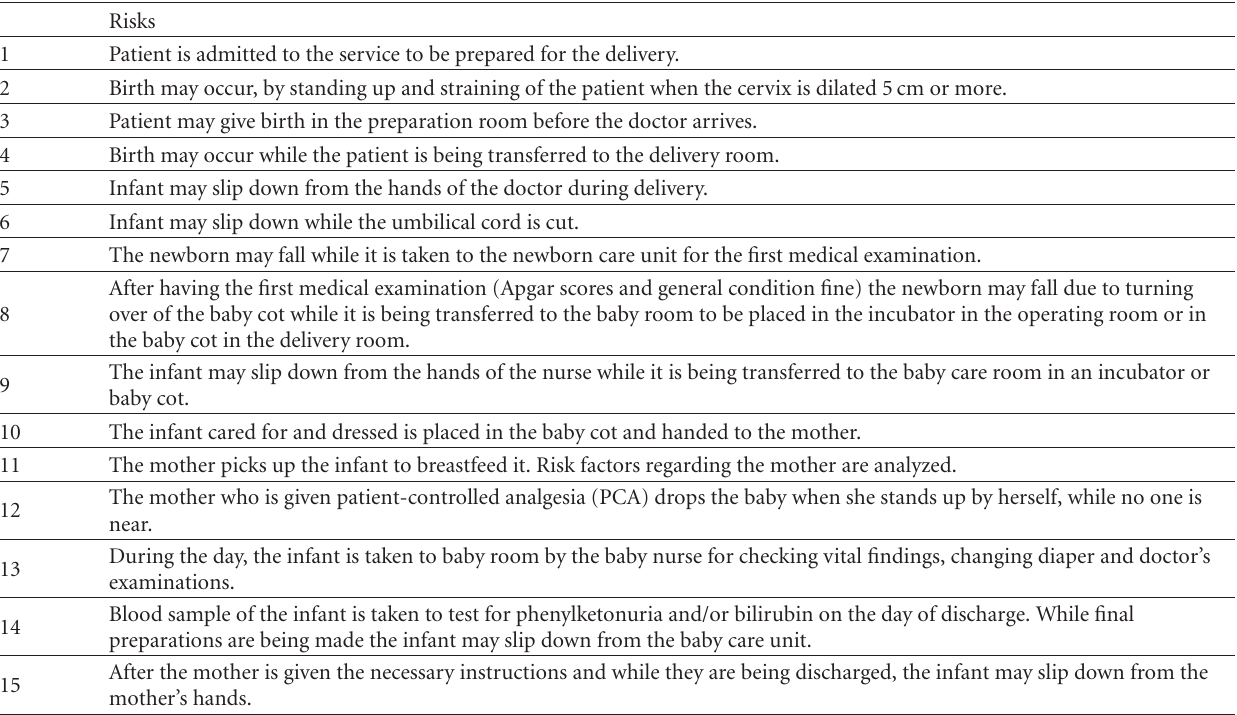
Table 1: Risks determined for in-hospital falls of